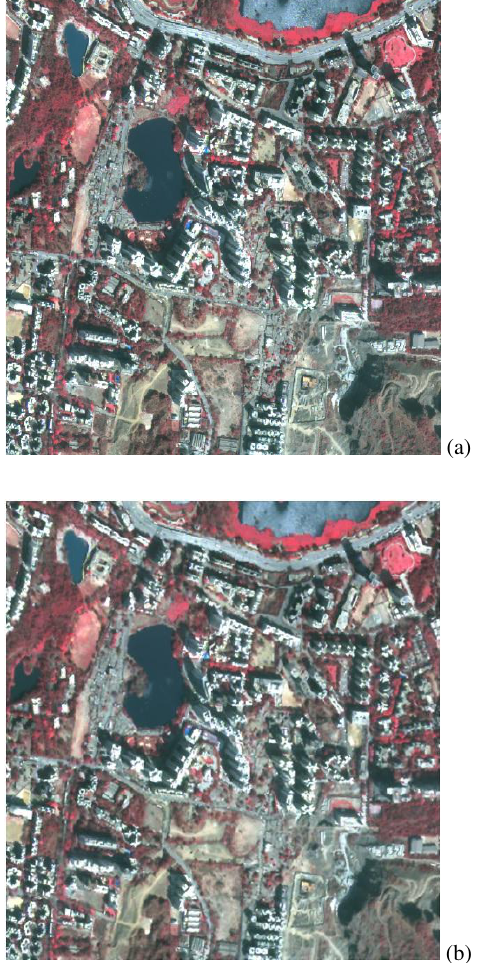
Figure 1: False colour composite of test image (a) Original (b) Smoothened by Wiener filter